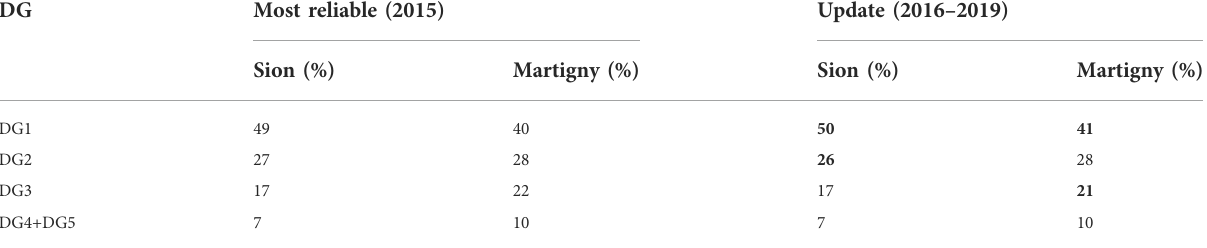
TABLE 4 Distributions of the overall building stocks into the damage grades (DG) for both cities. The update of the databases has a marginal impact (bolded values). DG